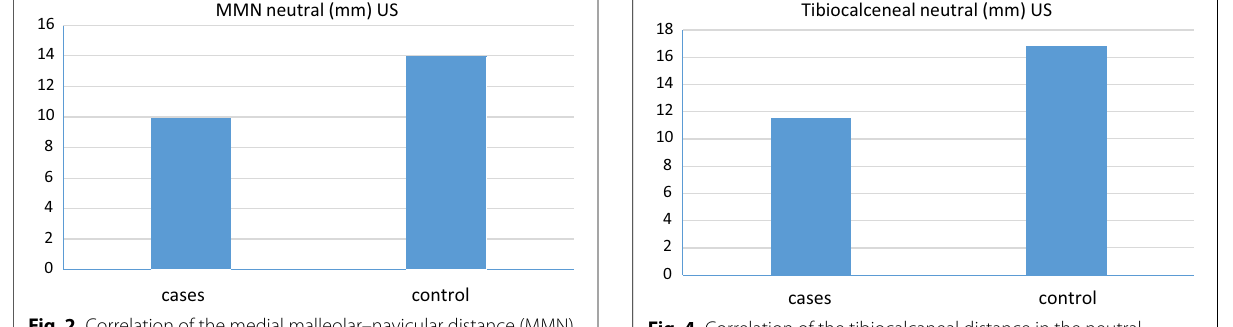
Fig. 4 Correlation of the tibiocalcaneal distance in the neutral position measured by US in patients and